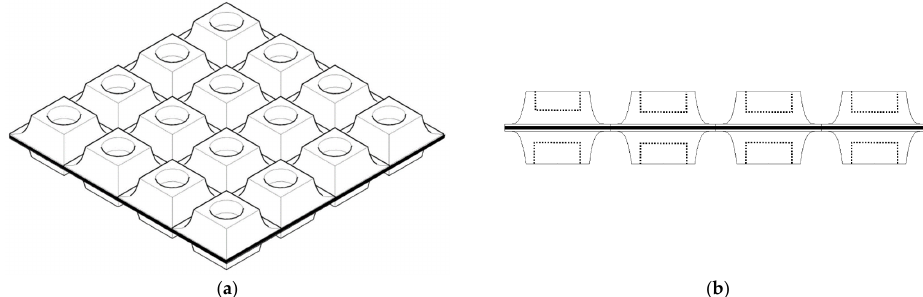
Figure 1. Periodic structure of the photonic crystal: ( a ) Oblique view; ( b ) Front view.